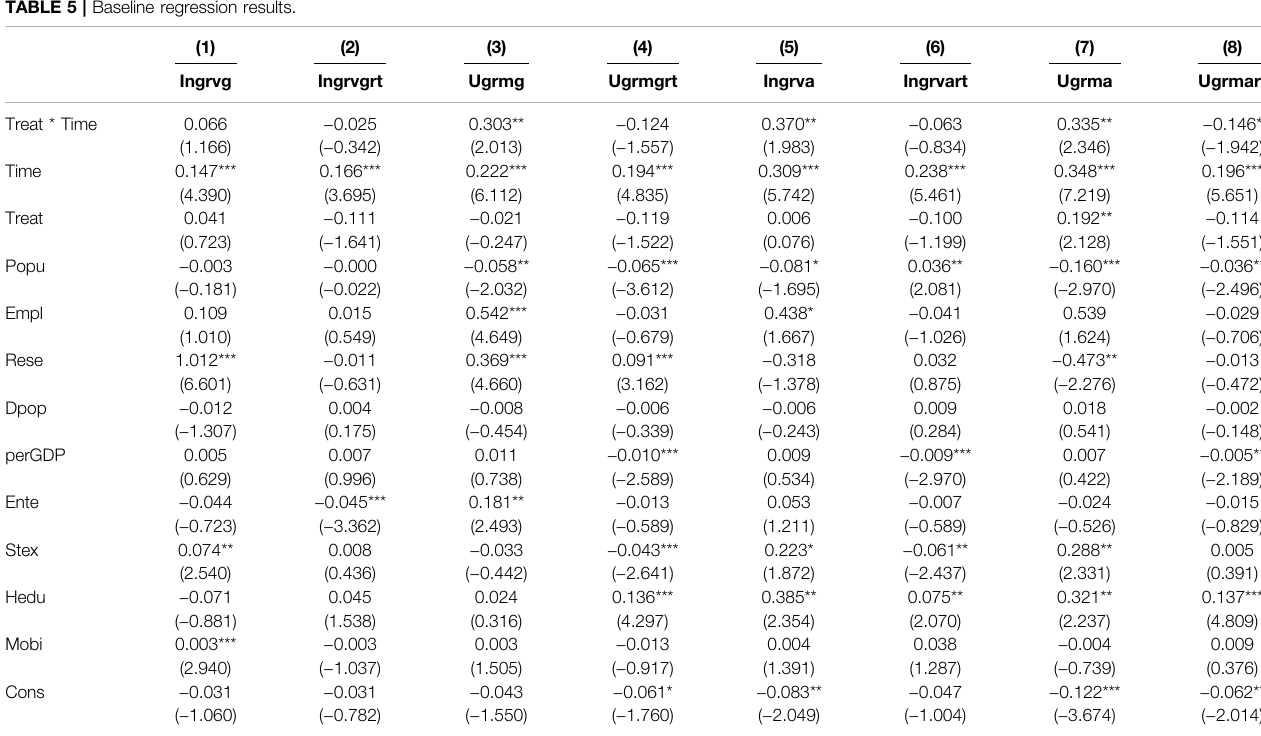
TABLE 5 | Baseline regression